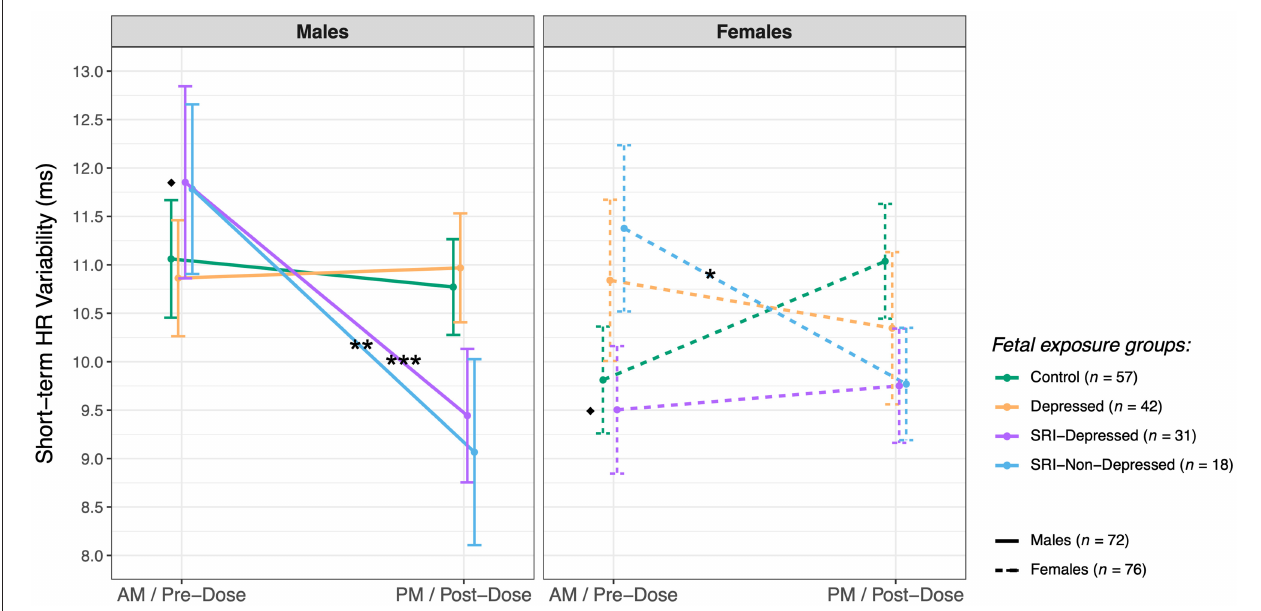
FIGURE 4 | Sex differences in fetal short-term HR variability (mean ± SE) between exposure groups ( post hoc test significance levels: * p < 0.05, ** p < 0.01, *** p < 0.001; *indicates within-sex group difference, (cid:7) indicates within-group sex difference).